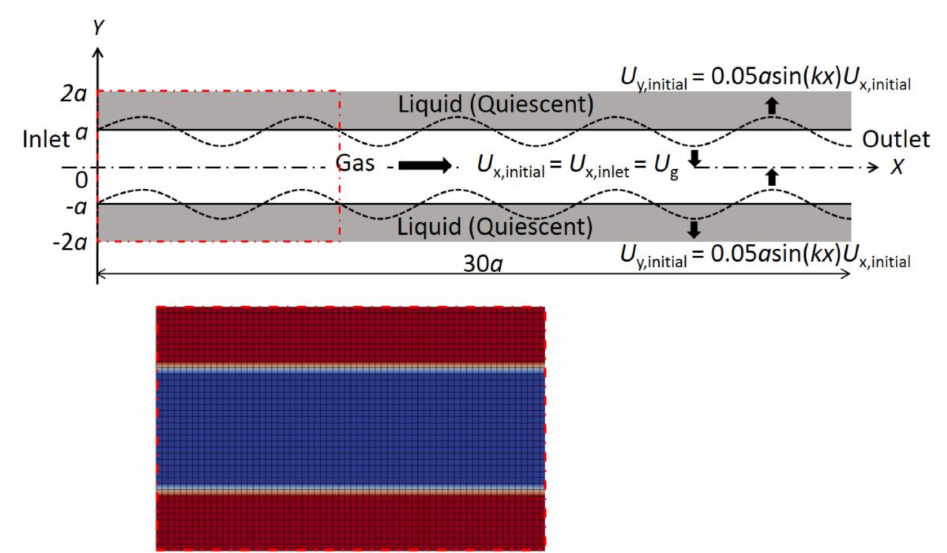
Figure 2. Schematic of the computational fluid dynamics (CFD) analysis configuration, initial and boundary conditions, and mesh applied in the case of 300 ( X direction) × 40 ( Y direction)